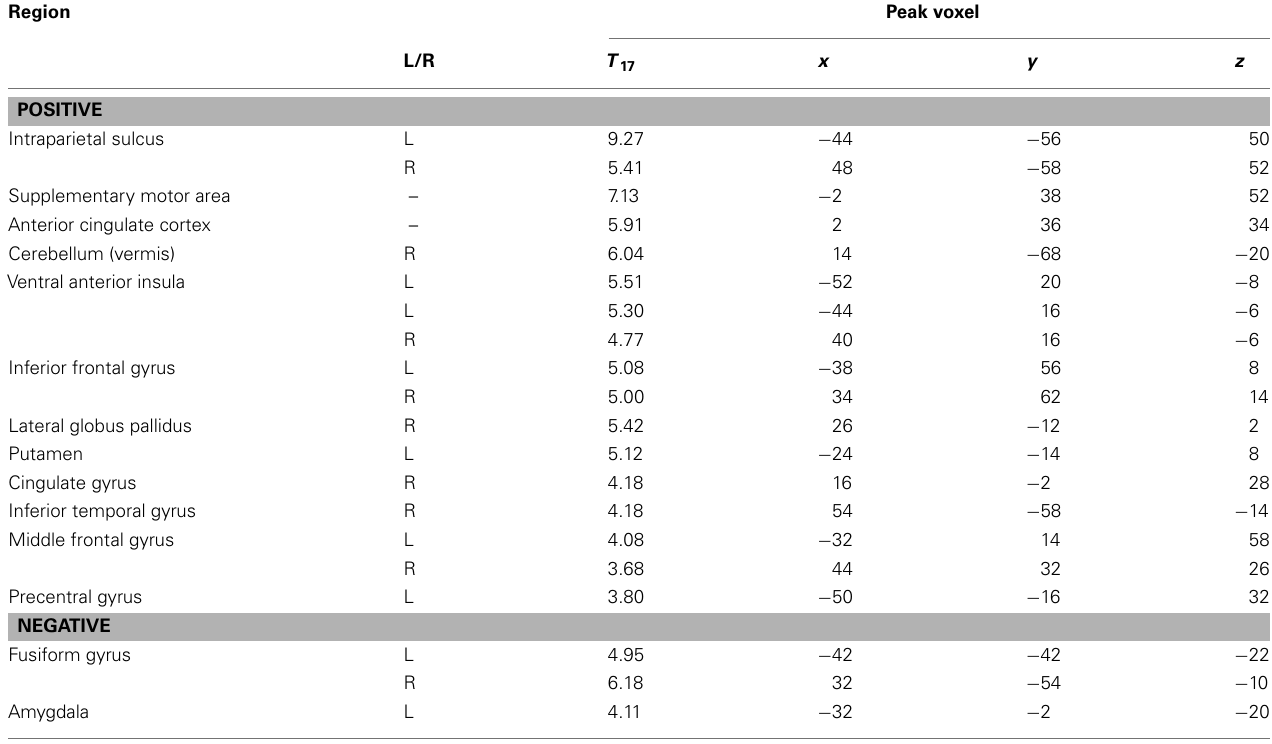
Table 1 | Correlation between activity during the choice period and the ratio of potential gains to losses.